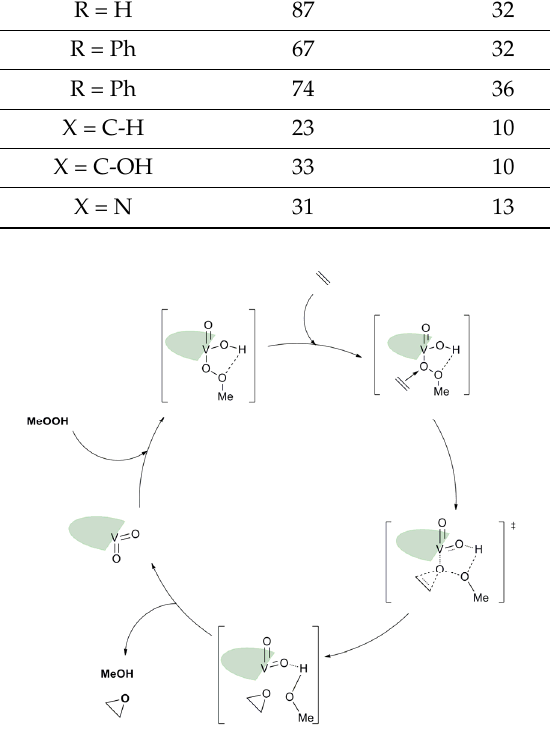
Figure 21. Schematic catalytic cycle proposed after DFT calculations with the [VO 2 (LH)] (X = C-OH) complex. The ligand was schemed with the green symbol.